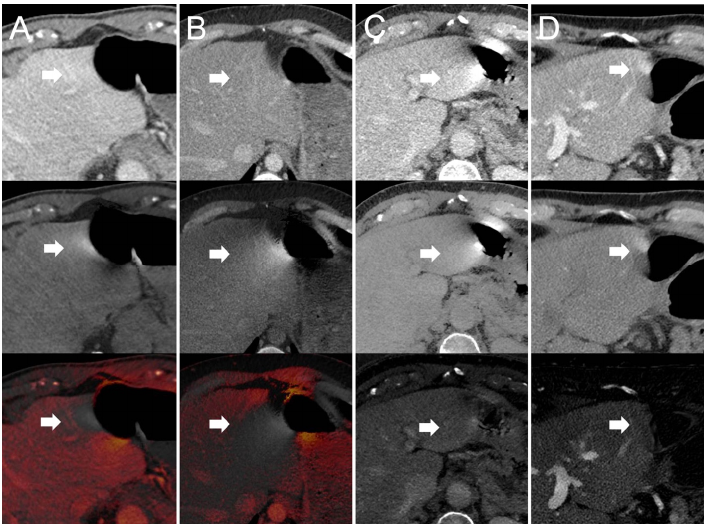
Figure 2. 120-kVp(-like) (top row), VNC (middle row), and iodine images (bottom row) acquired on a ( A ) dual-source, ( B ) twin-beam, ( C ) fast kV-switching, and ( D ) dual-layer spectral detector DECT scanner. Visceral-motion-related artifacts on the liver (arrows) in VNC (middle row) and iodine images (bottom row) acquired on a ( A ) dual-source DECT scanner and ( B ) twin-beam DECT scanner are substantially reduced in 120-kVp-like images (top row). Visceral-motion-related artifacts (arrows) in 120-kVp(-like) (top row) and VNC images (middle row) acquired on a ( C ) fast kV-switching DECT scanner and ( D ) dual-layer spectral detector DECT scanner are substantially reduced in iodine images (bottom row).